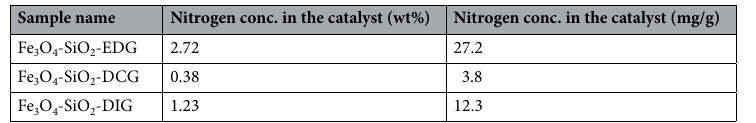
Table 2. Total organic nitrogen determined for the solid catalysts.